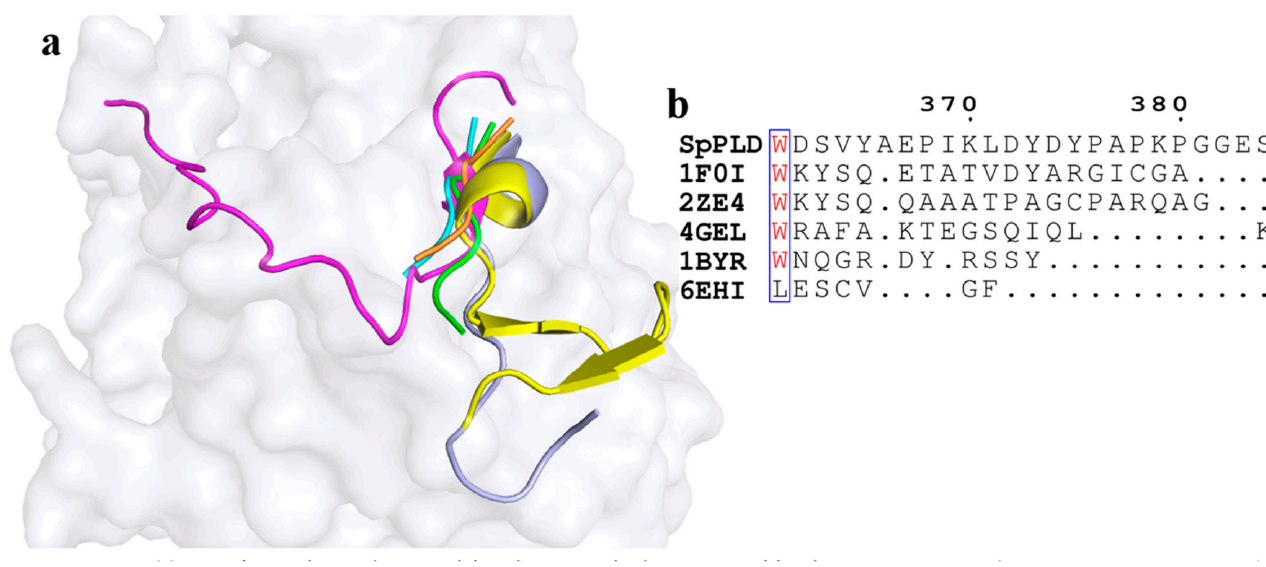
Figure 10. ( a ) Superimpostion and comparision the C-terminal structure with other PLDs. SpPLD (magentas, PDB ID: 7E0M), Streptomyces sp. PMF PLD (yellow, PDB ID: 1F0I), SaPLD (light blue, PDB ID: 2ZE4), Zuc (orange, PDB ID: 4GEL), NucT(cyans, PDB ID: 6EHI), Nuc (green, PDB ID: 1BYR). Two catalytic sites of SpPLD were shown in stick. ( b ) Sequence alignment of the amino acids that composed the C-terminal structure in SpPLD with other